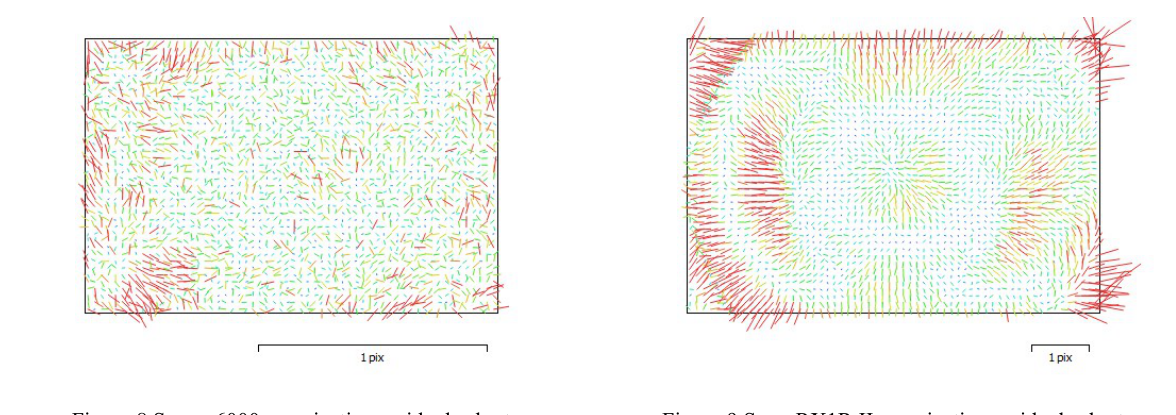
Figure 8 Sony a6000 reprojection residuals chart Figure 9 Sony RX1R II reprojection residuals chart